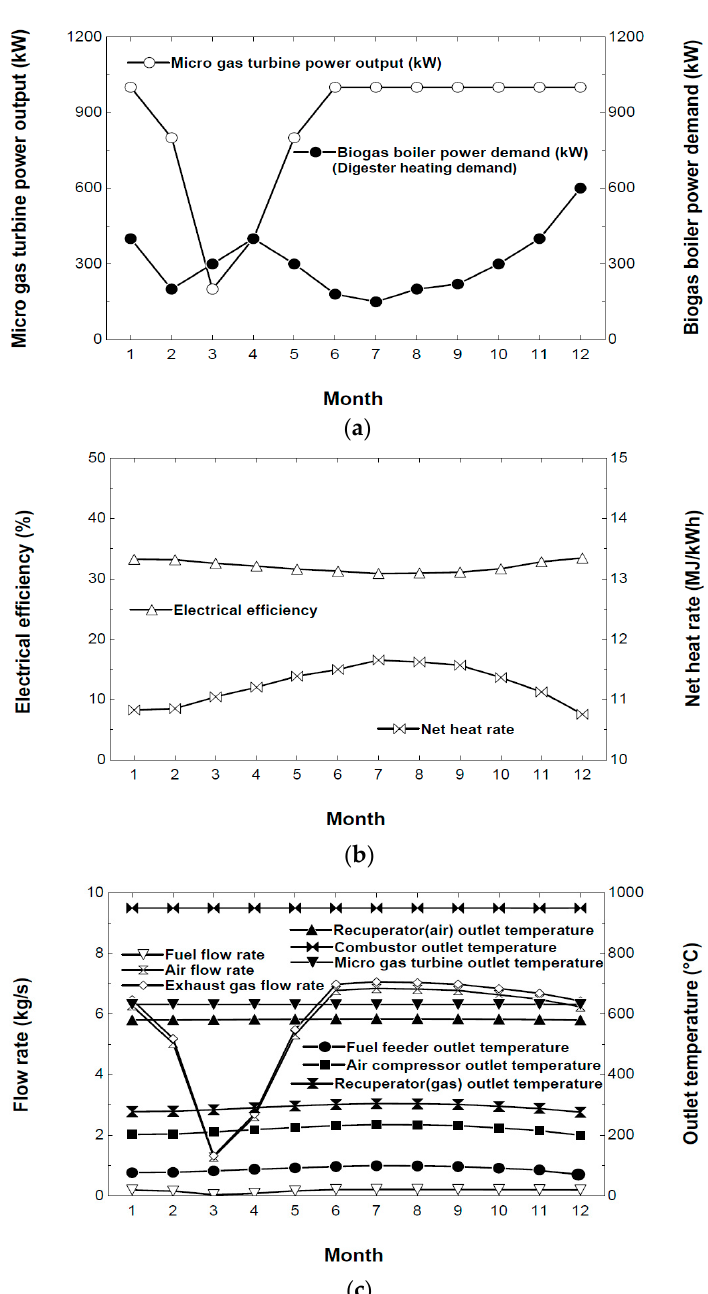
Figure 8. Annual operating results for MGT with biogas boiler system. ( a ) The power output of the MGT and the amount of the biogas used in the biogas boiler; ( b ) The electrical efficiency and the net heat rate of the MGT; ( c ) The mass rate and the outlet temperature for the streams in the MGT.